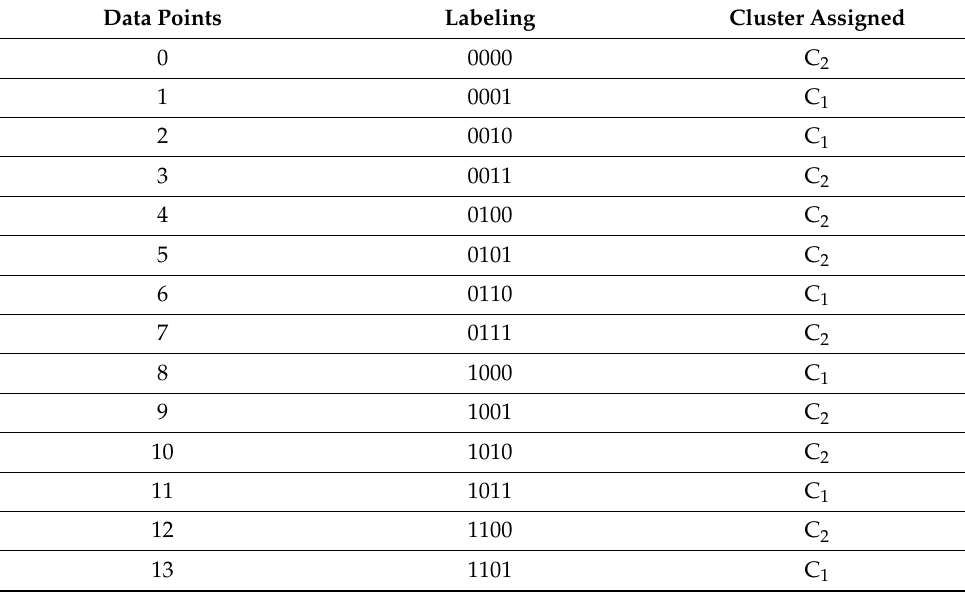
Table 6. Data points along with the labeling and cluster numbers (Mucormycosis dataset). Data Points Labeling Cluster Assigned 0